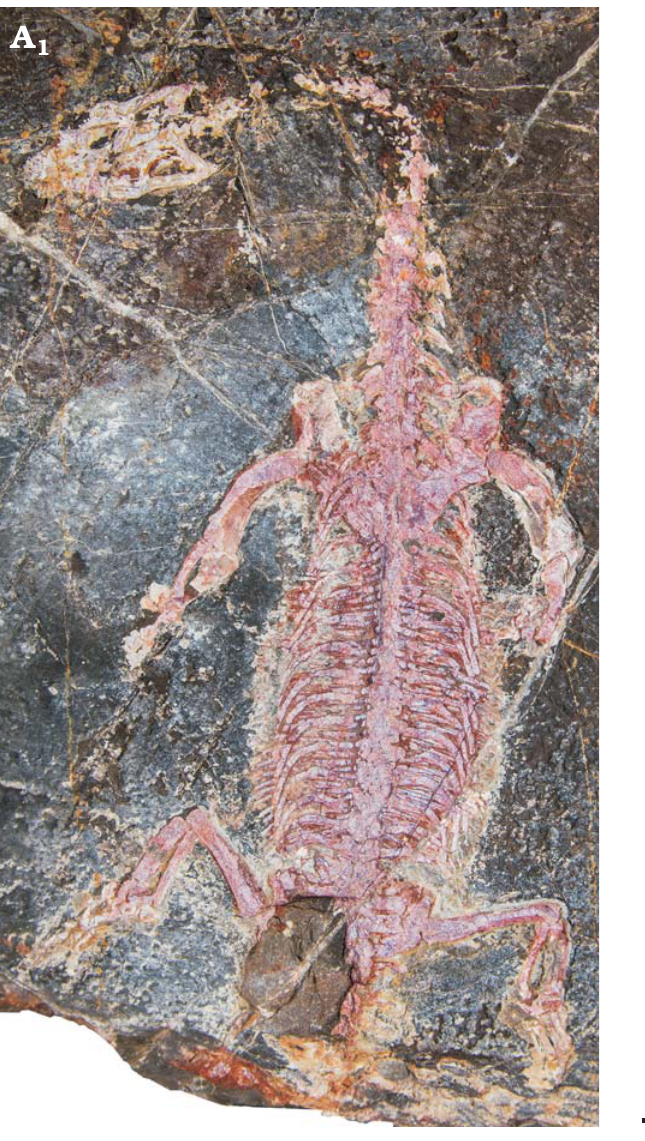
Fig. 3. Unidentified pachypleurosaur (YDBGLV_4) from the Triassic of Myanmar, in dorsal view. Most of the skeleton is preserved, except for the tail. ) and explanatory drawing (A ). For measurements see Table Photograph (A 1 2